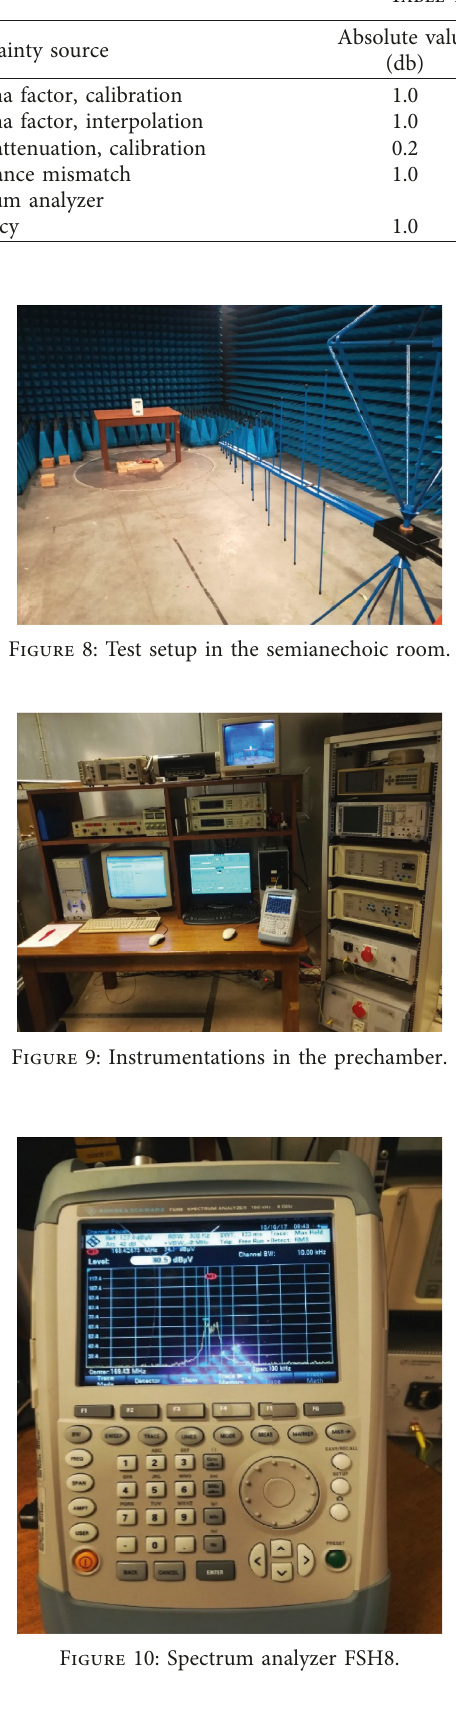
Table 1: Main uncertainty sources.